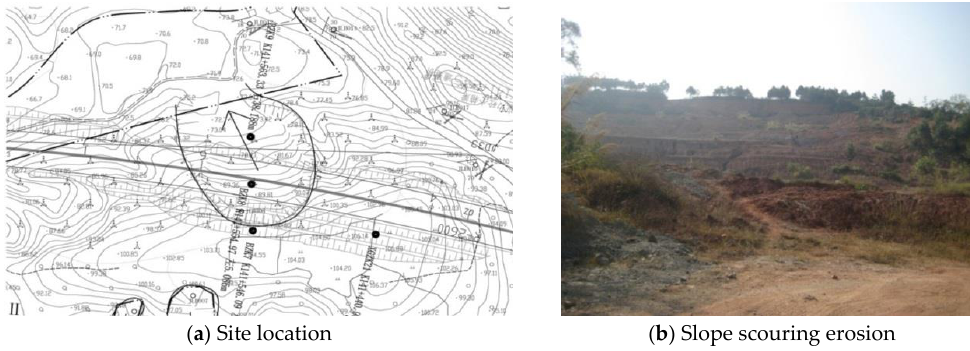
Figure 10. Slope scouring erosion of a slope in the expressway A, Guangdong, China.